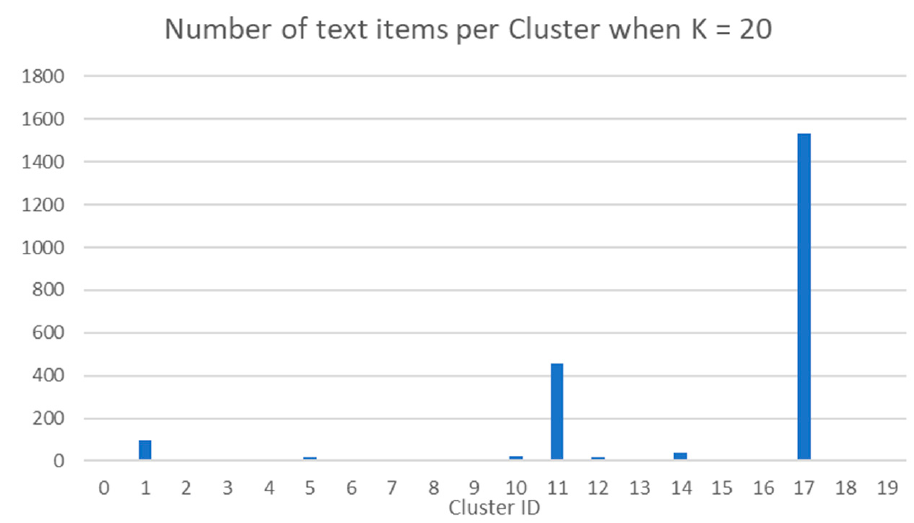
Figure 5. Distribution of LFE dataset when clustered using k -Means where k = 20.